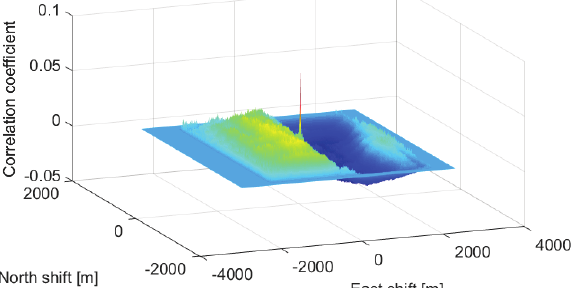
Figure 5. 2D cross-correlation of the edge images of TomoSAR and optical point clouds. Due to the pseudorandom nature of the urban infrastructure, a single prominent peak can always be found.